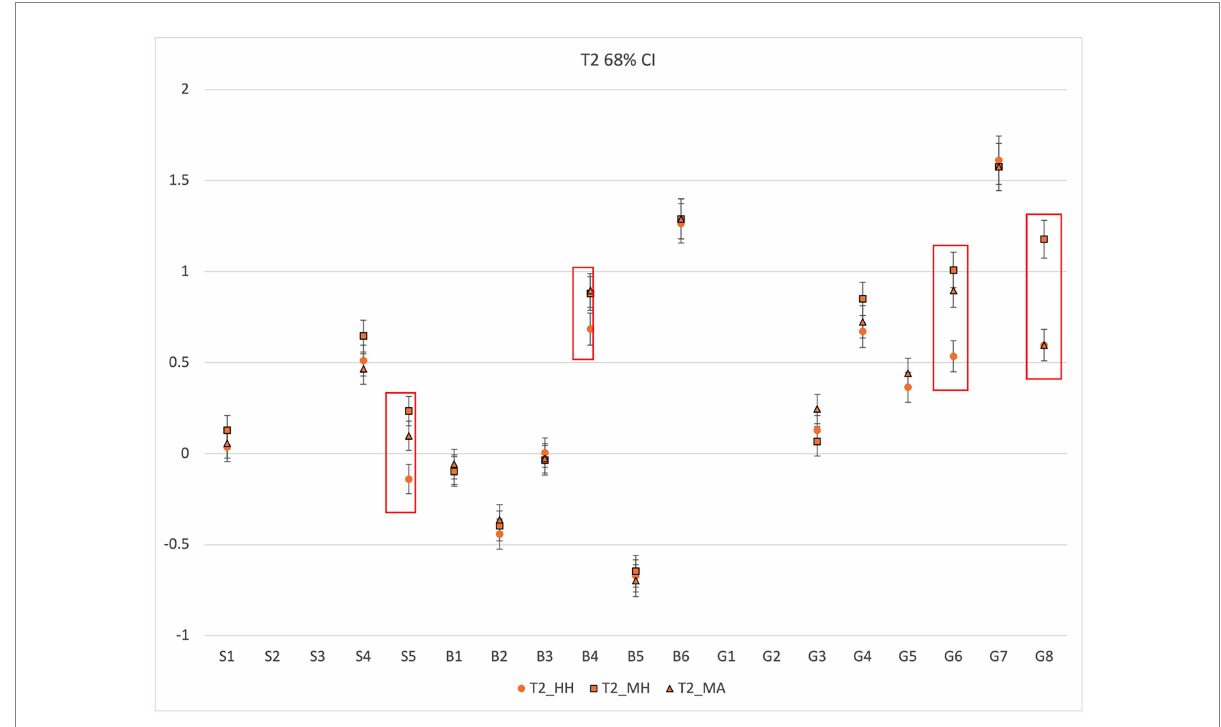
FIGURE 4 CFA threshold 2 with 68% CI for the HH, MA, and MH scoring